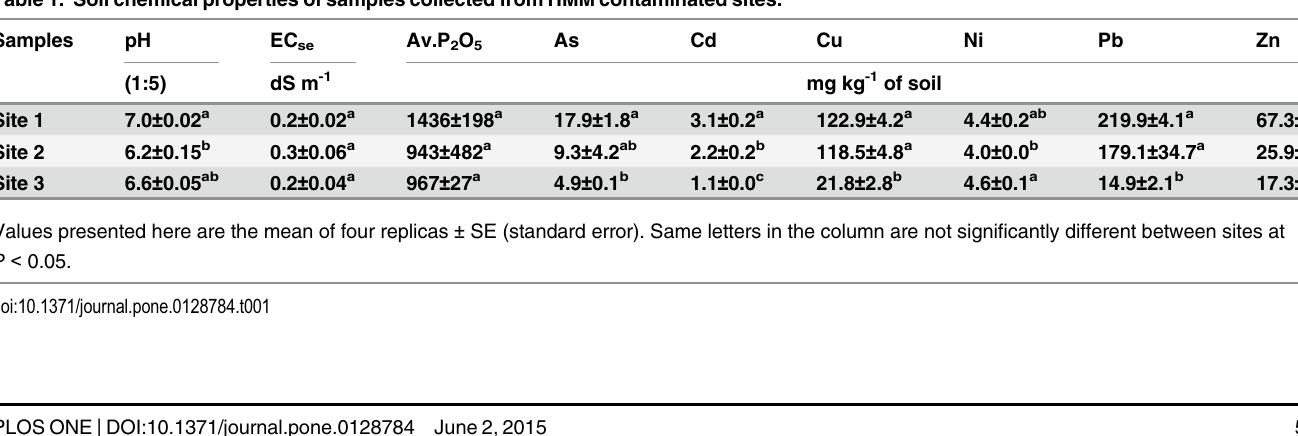
Table 1. Soil chemical properties of samples collected from HMM contaminated sites. Samples